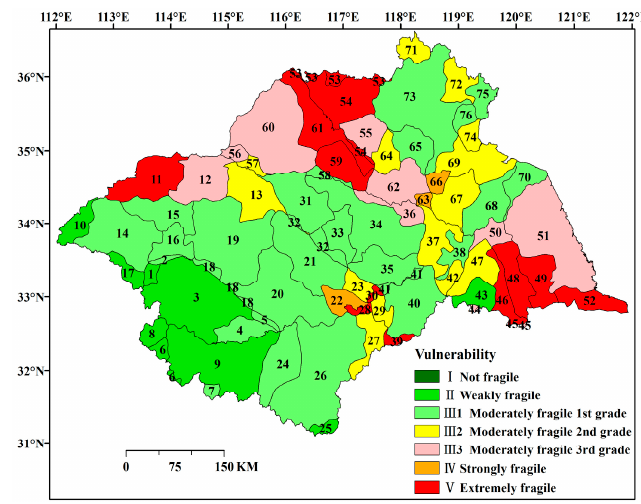
Figure 7. Water resource vulnerability in the Huai River Basin at the Municipality ‐ Class III WRR scale.